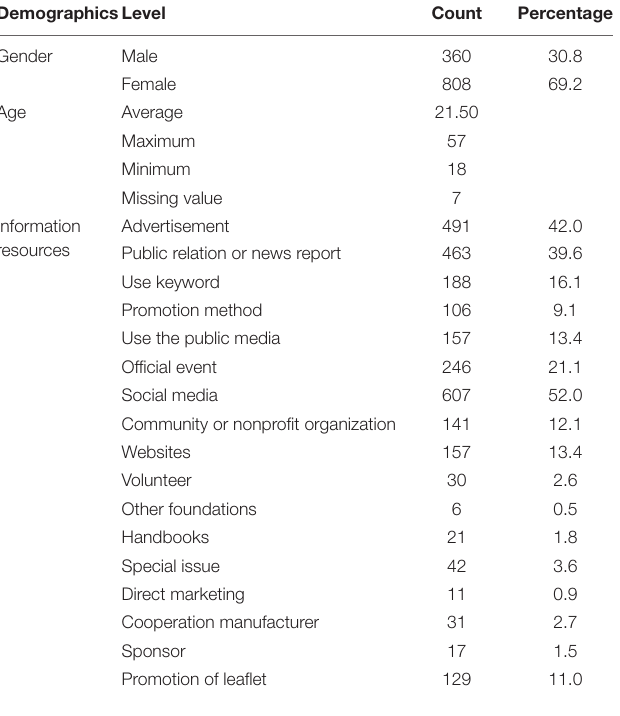
TABLE 1 | Respondent profiles.